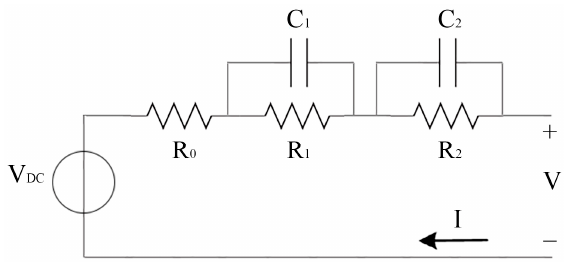
Figure 4. Equivalent model of battery.